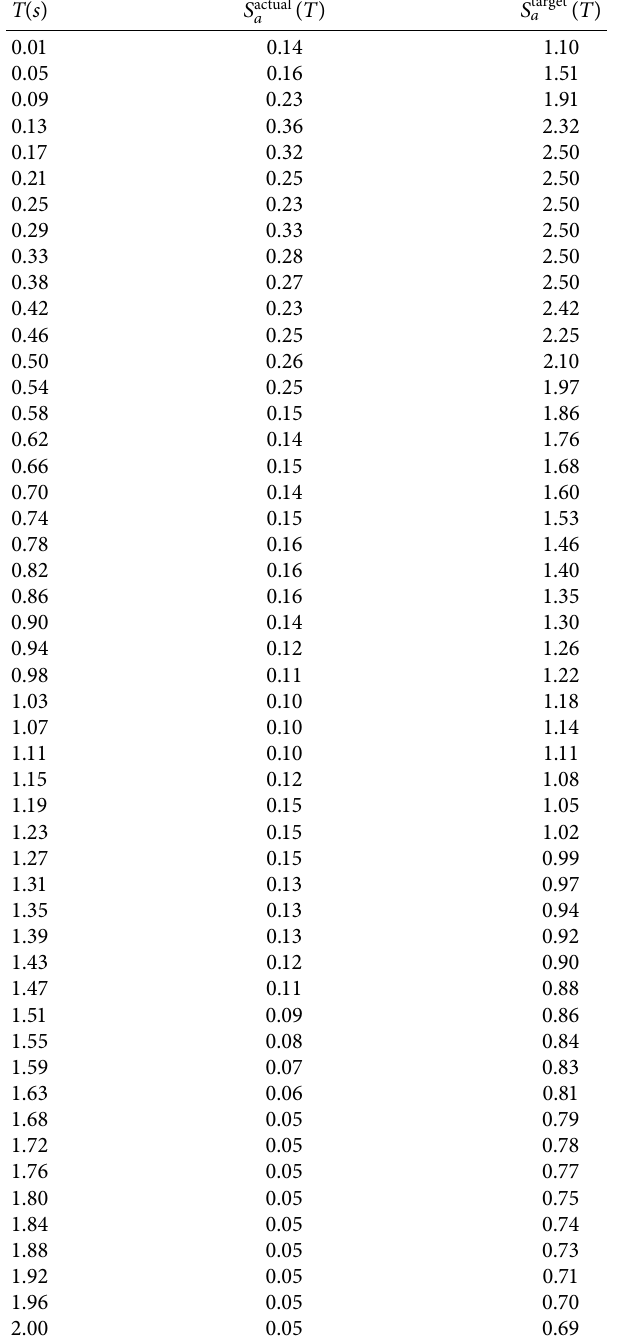
( T ) and S target a